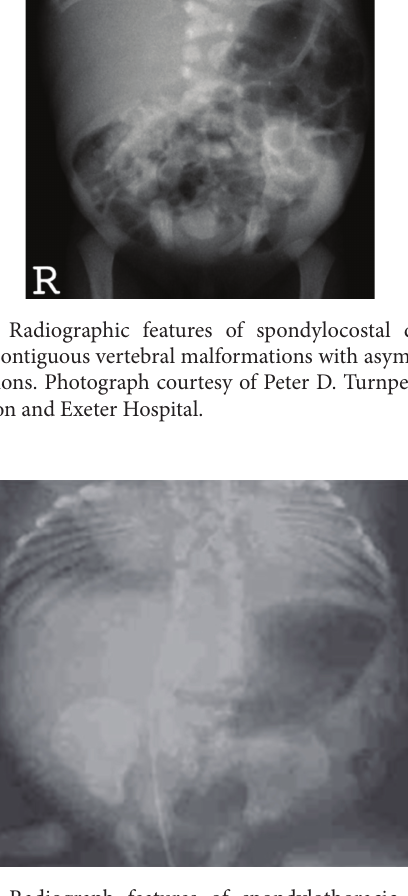
F 6: Radiograph features of spondylothoracic dysostosis demonstrating contiguous vertebral malformations with symmetric posterior rib fusion. Reproduced with permission Expert Opinion in